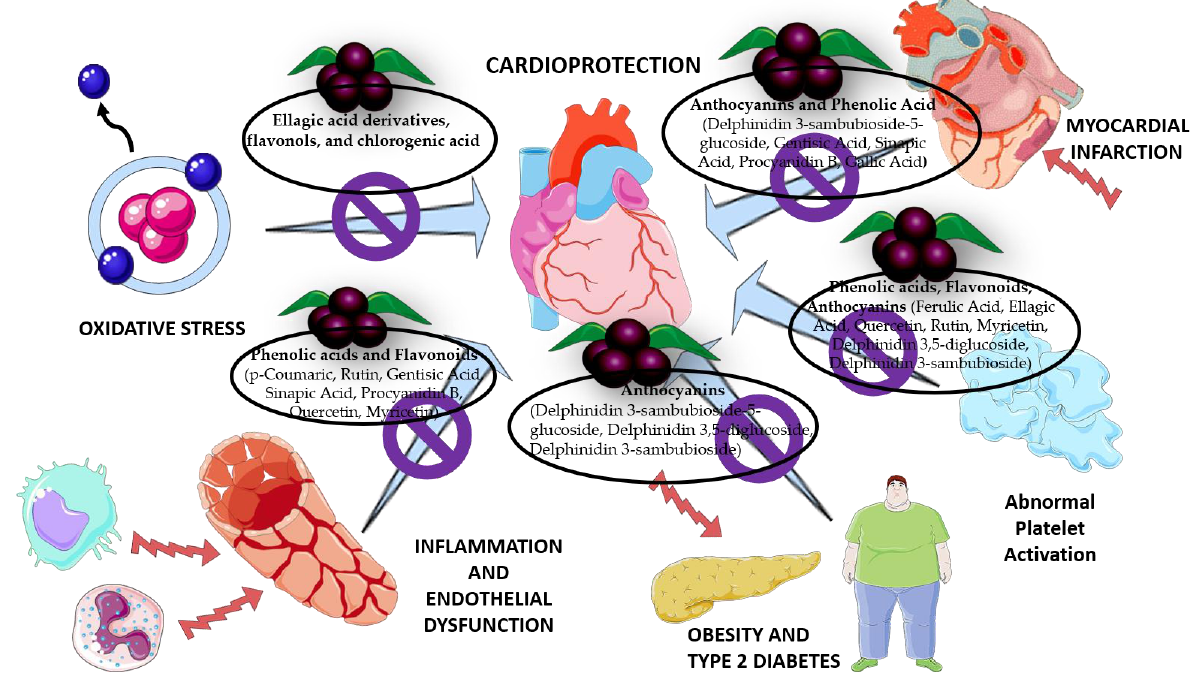
Figure 4. Cardioprotective effect of chemical compounds identified in Maqui.